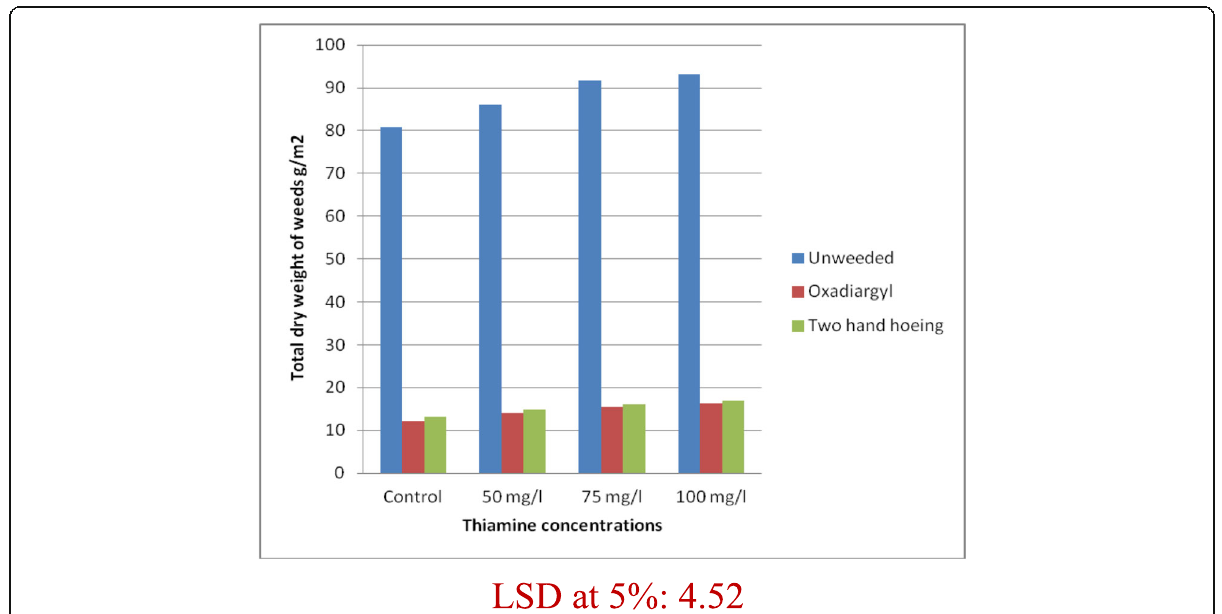
Fig. 2 Effect of the interaction between thiamine levels and weed control on total dry weight of weeds (g/m 2 ) faba bean at 60 days from sowing (combined analysis of two seasons)